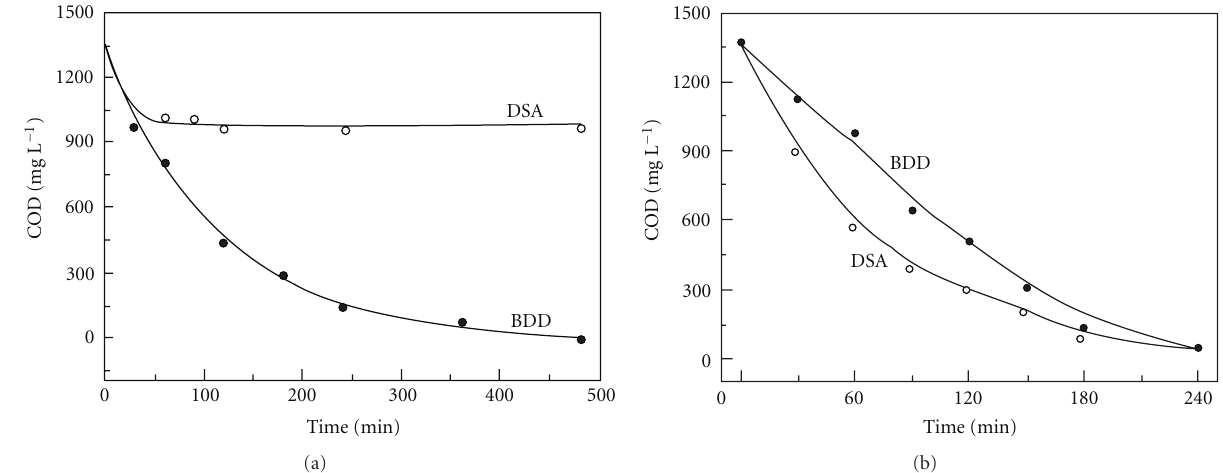
Figure 10: COD (a) in MB degradation in chloride-free wastewater and COD (b) in MB degradation in chloride-mediated wastewater